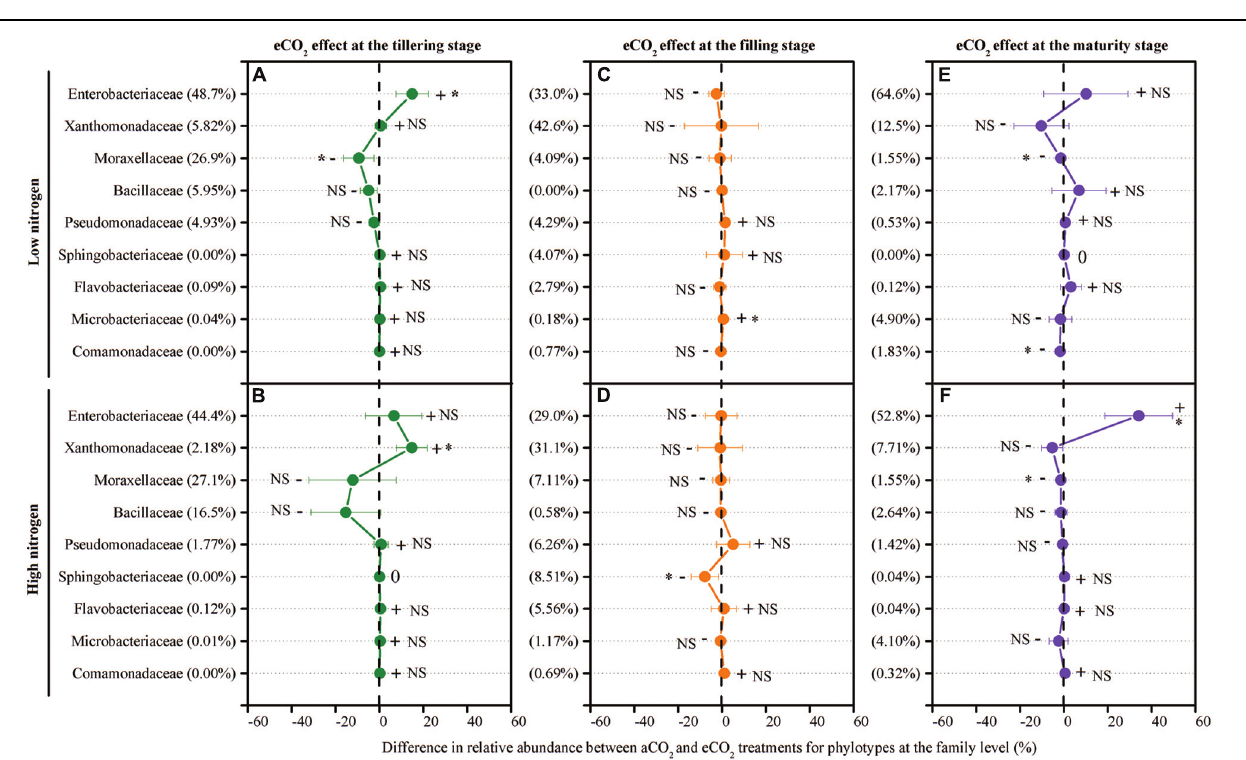
refers to the relative abundance at aCO 2 . The error bar denotes the standard error of the mean. The phylotypes are presented in generally descending order based on their relative abundance in the aCO 2 control treatment. The symbols “ + ”, “ − ”, and “0” indicate that the relative abundance was increased, decreased, or stable compared with the aCO 2 control treatment. The symbol “ ∗ ” represents significant differences at P < 0.05, and NS represents no significant difference ( P > 0.05). All other designations are the same as those in Figure 1